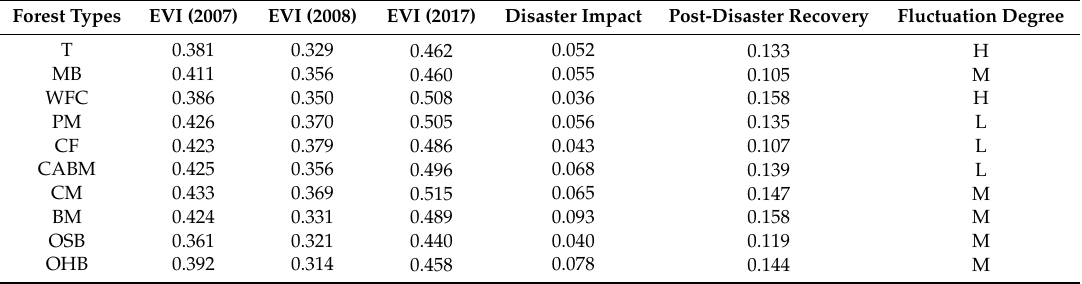
Table 7. Details of the disaster impact and post-disaster recovery for di ff erent forest